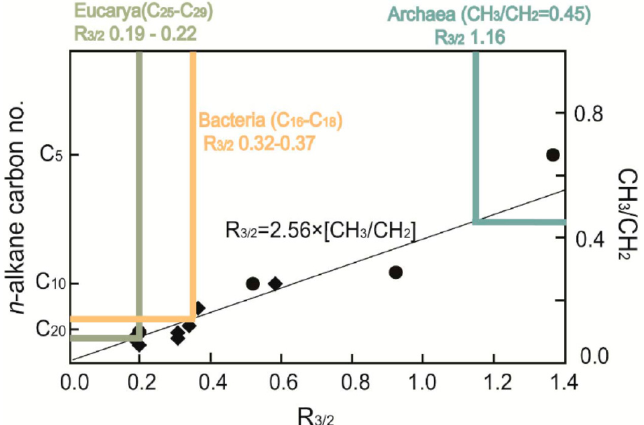
Figure 11. Relationship between R 3/2 (aliphatic CH 3 /CH 2 absorbance ratios) and ratio of CH 3 /CH 2 for n -alkane standard samples ( n -C 5 to n -C 40 ). The CH 3 /CH 2 ratio can be converted to carbon number of the n -alkane. Modified after figure 6 in Igisu et al. [142] with copyright permission from Elsevier. Using this equation, R 3/2 values of Eucarya, Bacterial and Archaeal lipids are estimated to be 0.19–0.22, 0.32–0.37, and 1.16, respectively [142]. The carbon number of Eucarya lipids (C 25 –C 29 ) and bacterial lipids (C 16 –C 18 ) are from Han and Calvin [143] and Ladygina et al. [144].